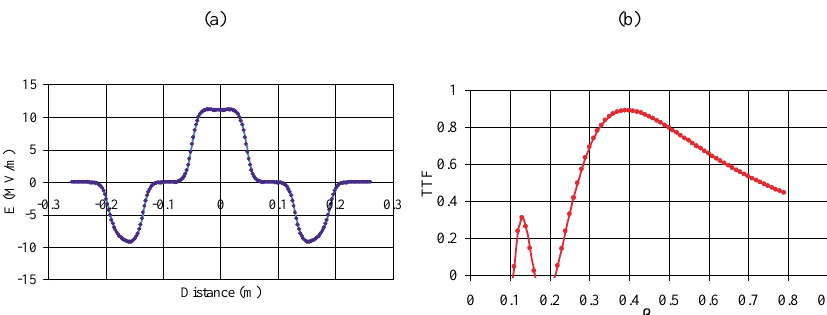
FIG. 3. (Color) Axial electric field distribution (a) and transit time factor (b) of the three-gap SC spoke cavity, E 0 T (cid:1) 5 MV (cid:2) m, b G (cid:1) 0.38